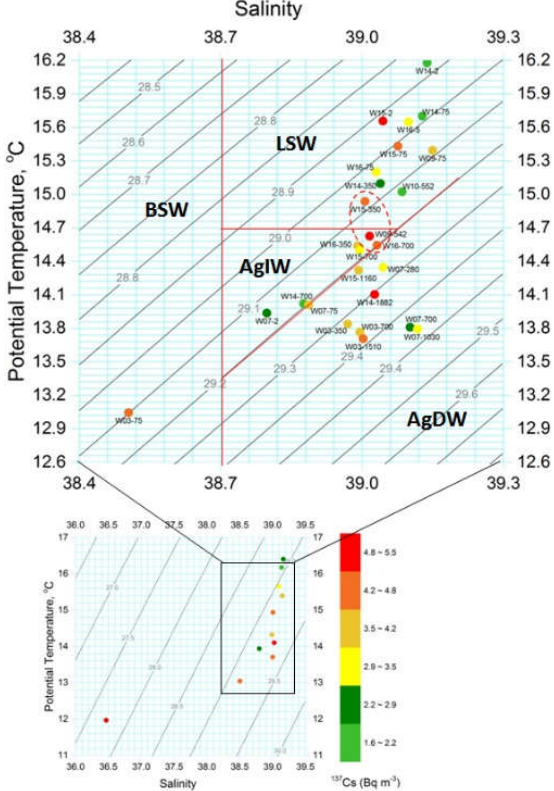
Figure 3. The T/S diagrams and 137 Cs activity concentrations during the R/V “AEGEAON” Cruise in the Aegean Sea, winter 2017. Each sampling point is labeled with the station name followed by the sampling depth. Red lines are isosurfaces indicating the boundaries between main water masses found in the Aegean Sea according to literature [23], while the dotted ellipse represents the TSAW masses of this work.